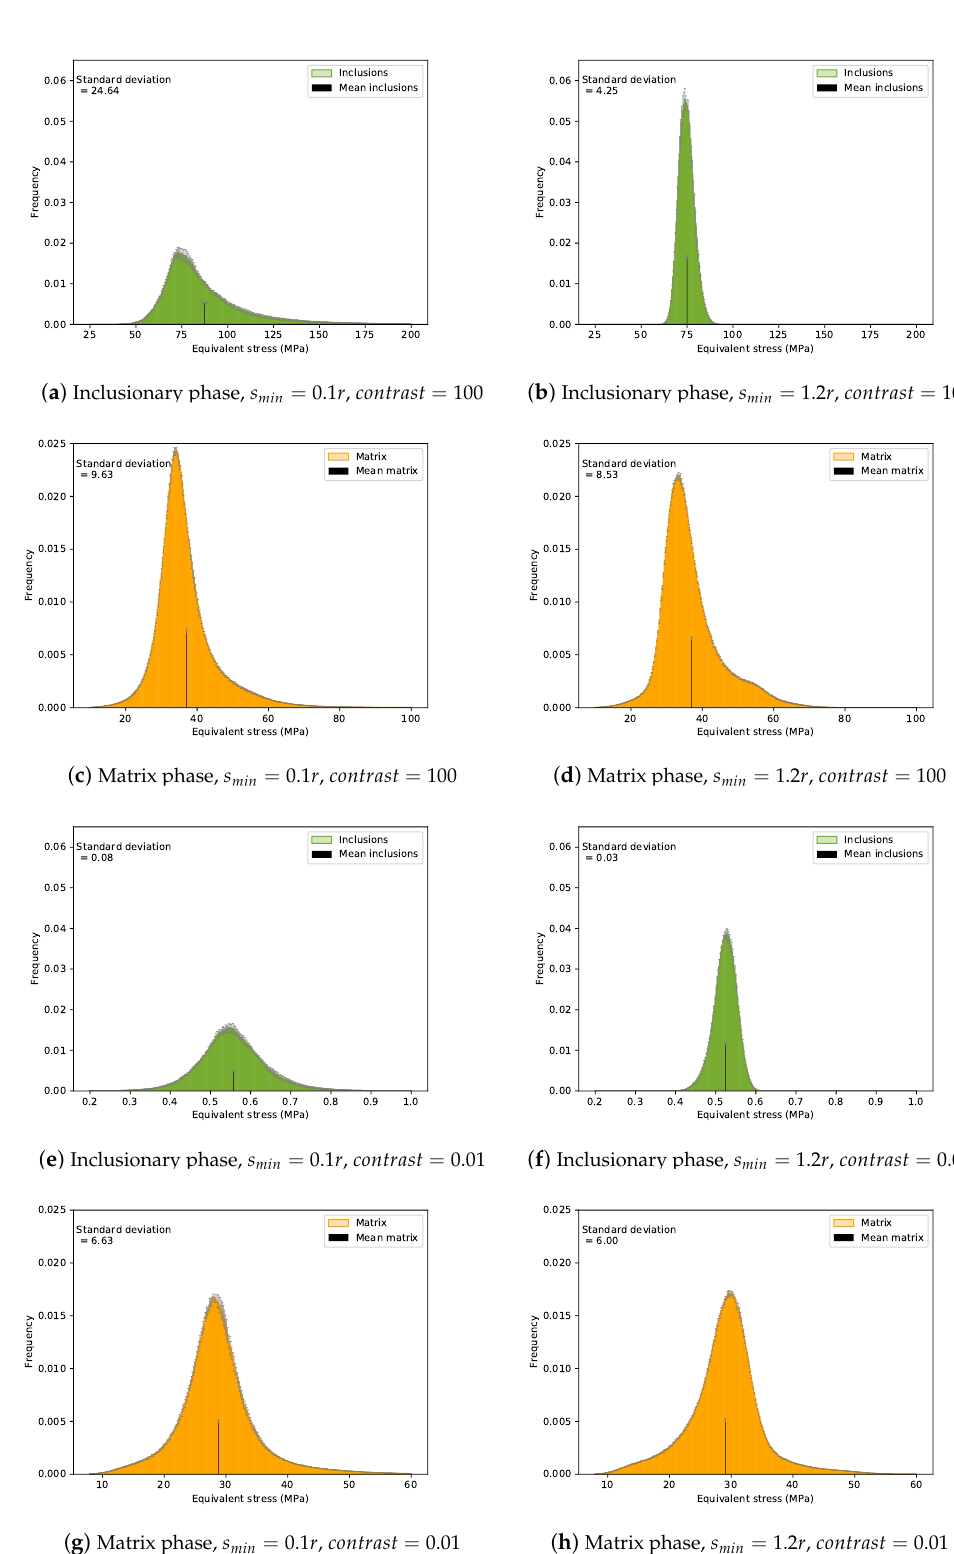
Figure 9. Frequency histograms of equivalent stress by phase at SR = 10, f v = 13.4 %, and the extreme s min values ( s min = 0.1 r and s min = 1.2 r ) for contrasts of 0.01 and